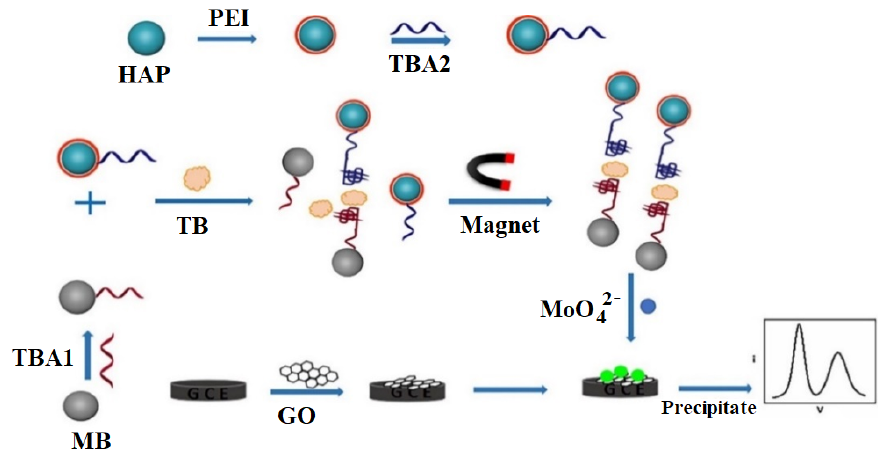
Figure 9. Principle of the magnetic nanoparticle-based aptasensor developed by Zhang et al. (MB: magnetic bead). Adapted from [115].